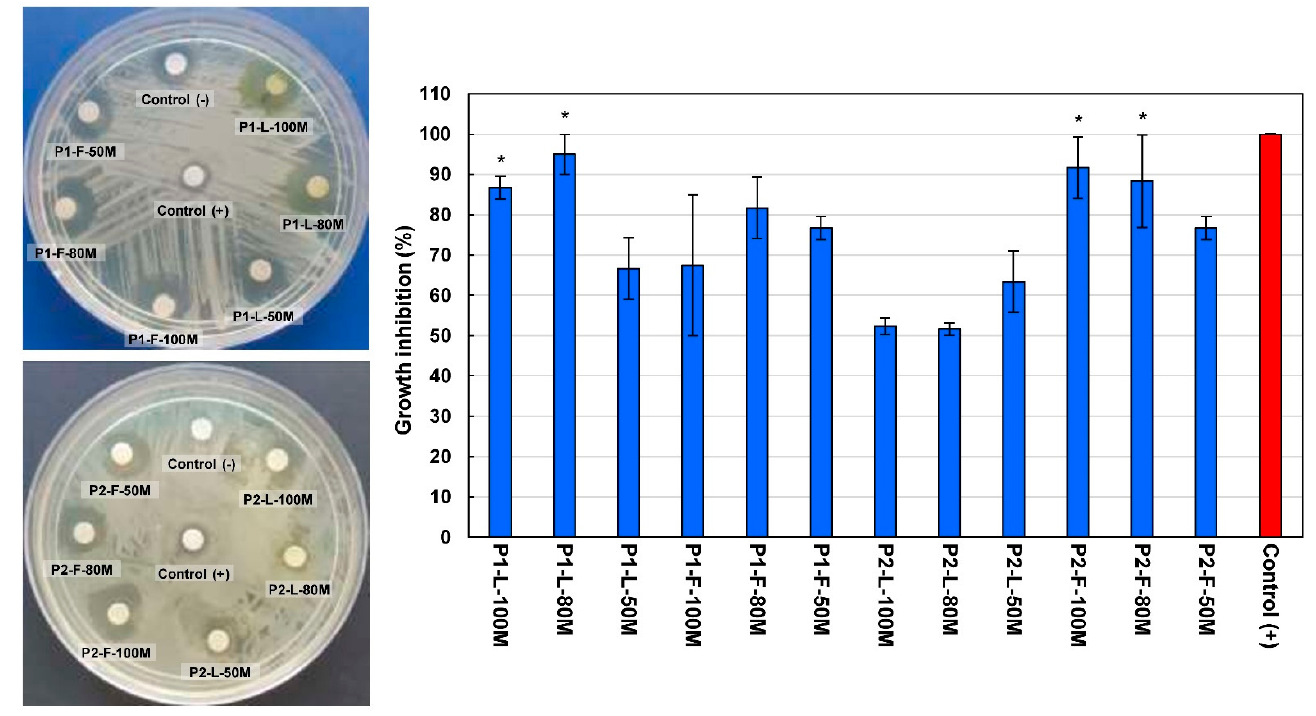
Figure 4. Antibacterial activity of methanolic extracts from Verbesina sphaerocephala leaves and flowers against Escherichia coli . Values are expressed as mean ± standard deviation of three repetitions. Abbreviations: P1, Population 1; P2, Population 2; L, leaves; F, flowers; 100M, extracted with 100% methanol; 80M, extracted with 80% methanol; 50M, extracted with 50% methanol; Control (+), ampicillin 10 mg/mL; Control (-), methanol/DMSO. (*) Indicates no significant statistical difference from the control according to Dunnett’s test ( p < 0.05).